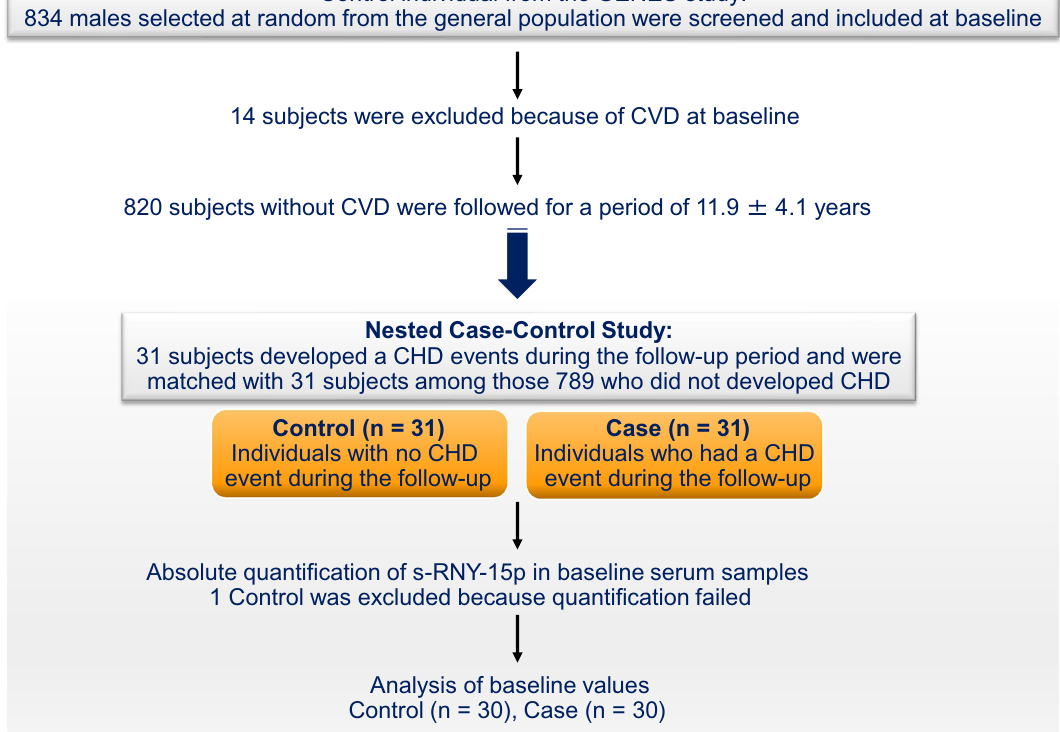
Figure 1. Study flowchart. Cases (n = 31) were male subjects from the GENES study (n = 834) who experienced a Coronary Heart Disease (CHD) events during the follow-up period (11.9 ± 4.1 years). The control subjects (n = 31), matched for age and date of recruitment, were participants who remained free of cardiovascular diseases and stroke during follow-up. One Control was excluded because quantification of s-RNY1-5p in baseline serum failed. Analyses were thus based on a nested case–control population of 30 case patients and 30 control participants from the GENES